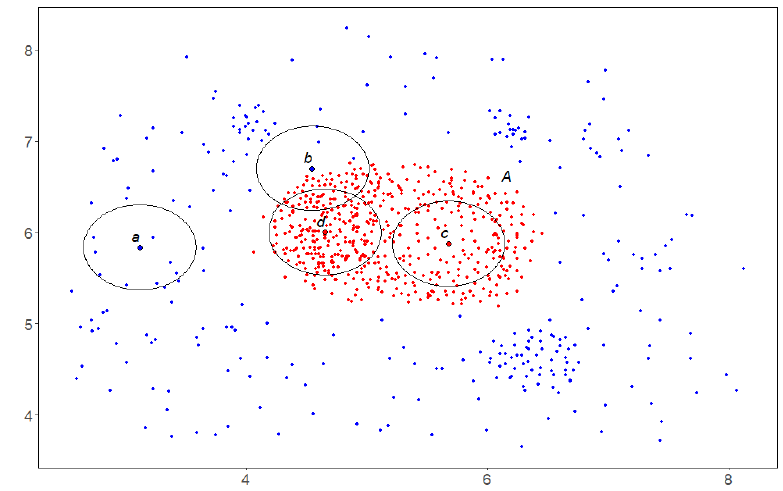
Figure 1. The concept of density relative to a set. A —a set of red dots, in which four points a , b , c and d are highlighted. The density S of the subset A at the selected points is equal to the number of red points included in the balls described around them. The densest point relative to A will be point c , followed by points b , d and a